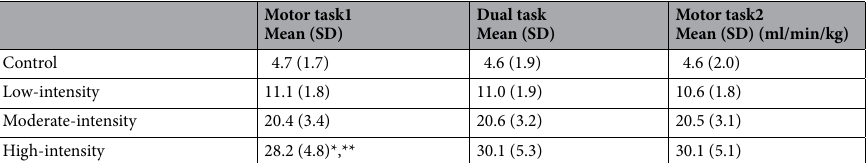
Table 1. Mean oxygen uptake levels under different exercise intensity conditions. *Significant difference between M1 and DT under the high-intensity condition in post-hoc analysis. **Significant difference between M1 and M2 under the high-intensity condition in post-hoc